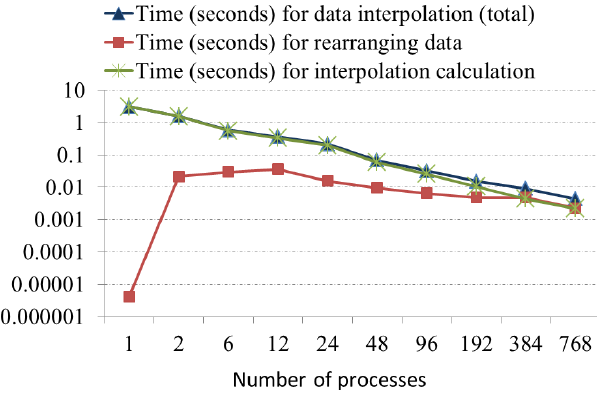
Fig. 11. The scaling performance of a 3-D interpolation in the MASNUM-POM: interpolating the 3-D field wave-induced mixing coefficient from the 3-D grid of MASNUM to the 3-D grid of POM on the POM.